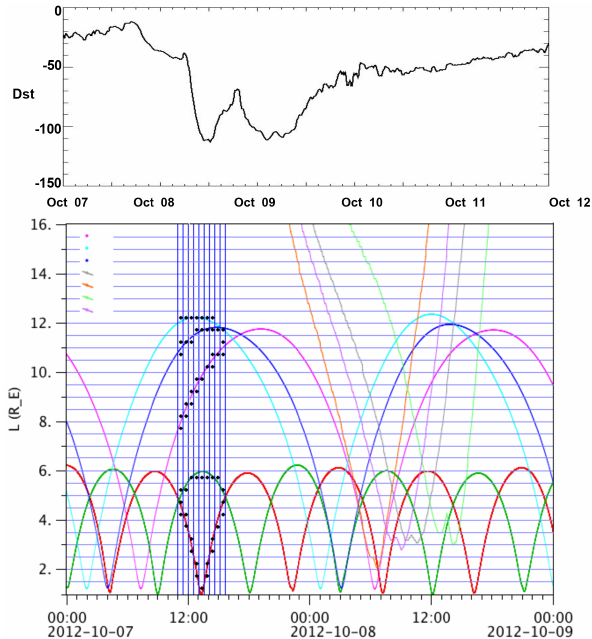
Figure 1. (a) Dst index from 7 to 12 October 2012 and (b) sample L shell coverage of the Van Allen probes A and B (red and green lines, respectively) and the THEMIS probes A, D and E (purple, light blue and blue,